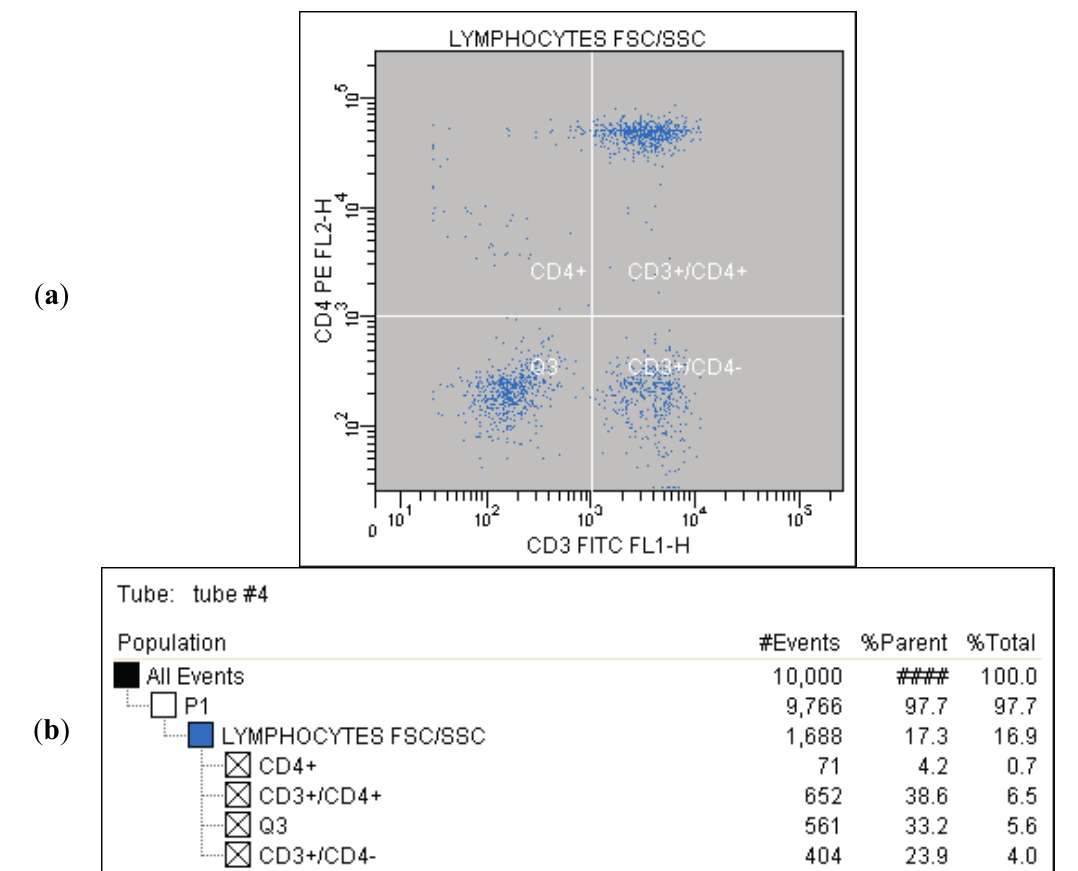
Figure 5. ( a ) Tube No. 4; Dot plot of CD3 FITC/CD4 PE with quadrant markers, differentiating lymphocytes T helper (CD3 + /CD4 + ) from all lymphocytes; ( b ) Tube No. 4; Gating tree showing gating strategy for FACS analysis as well as parent and total cell percentages within each of the gates for CD4 + and CD3 +